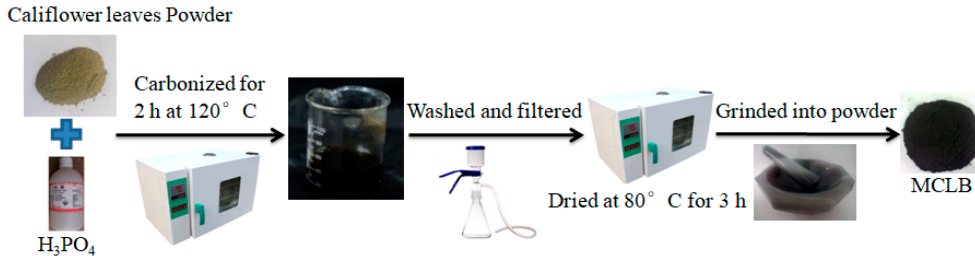
Figure 1. Preparation process of cauliflower leaves biochar (CLB) from cauliflower leaves.